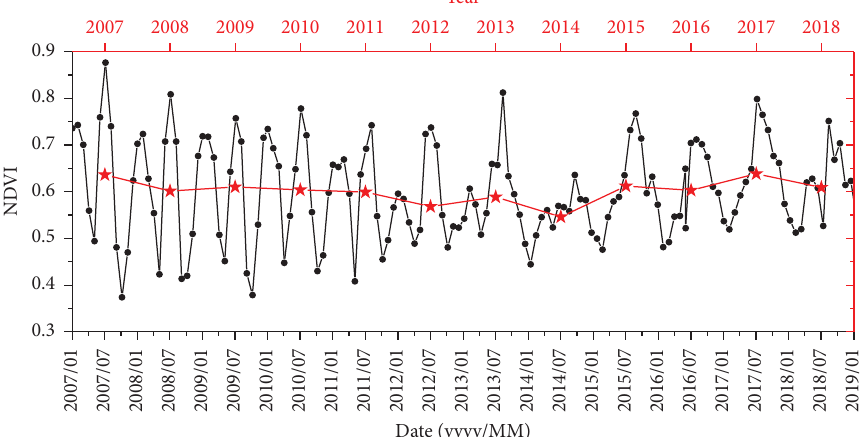
Figure 6: Seasonal and interannual variations of the normalized diference vegetation index (NDVI) at 250 m spatial resolution and 16-day temporal resolution from 2007 to